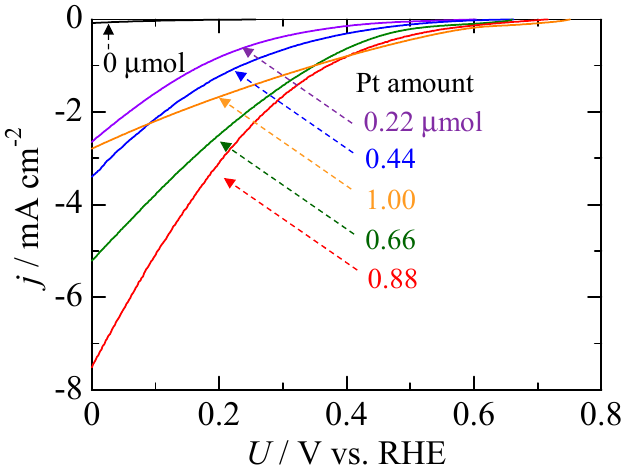
Figure 5. Polarization curves of Pt / CdS / CuInS 2 photoelectrodes measured under visible light irradiation ( λ > 420 nm).